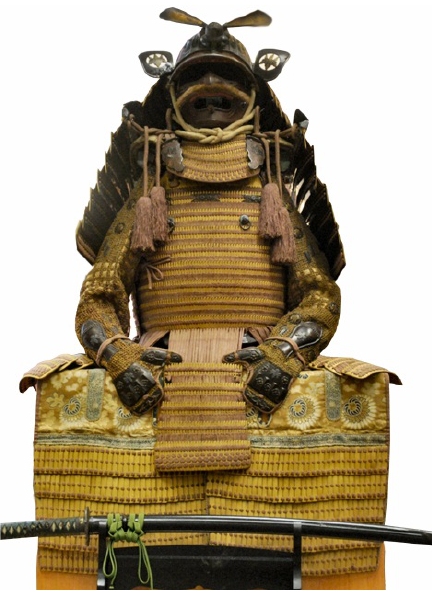
Figure 2 This samurai armor, located on the main floor of Musselman Library, is a common source of inquiries, making it an ideal candidate for the artiFACTS